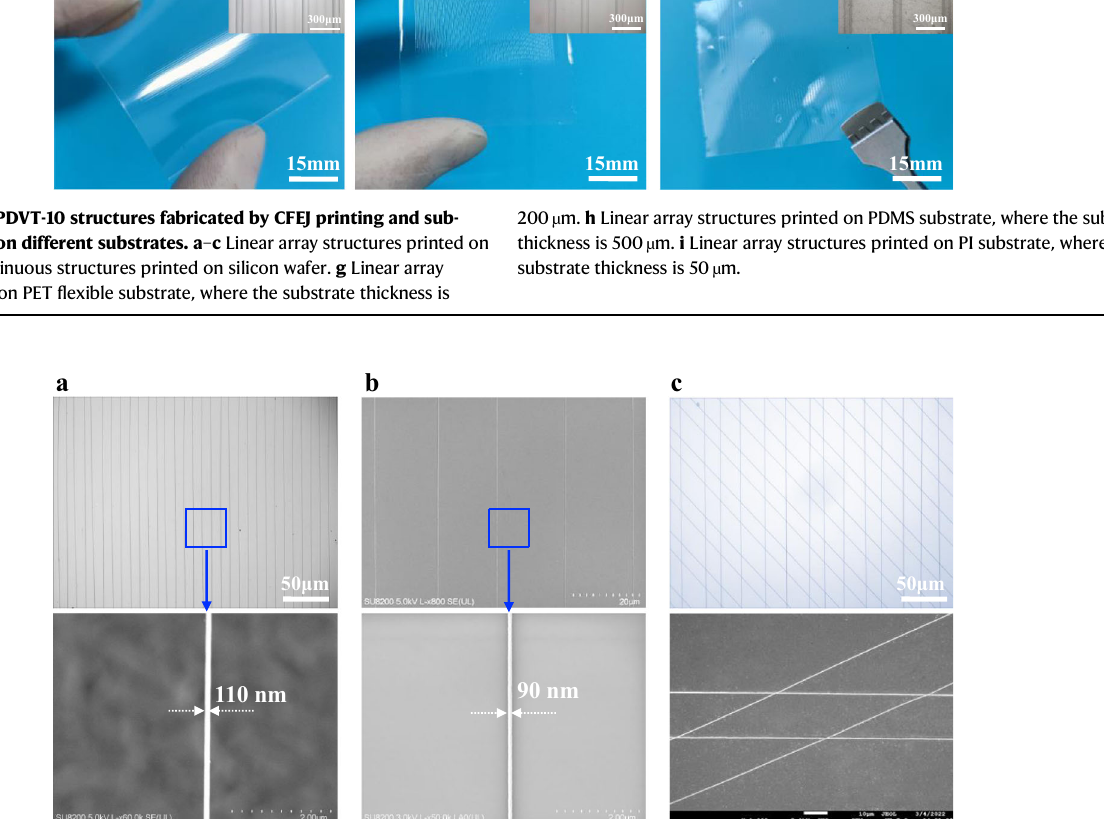
Fig. 3 | Images of various PDVT-10 micro/nanowire arrays fabricated by CFEJ printing. a Aligned sub-microwire arrays printed with a width of ∼ 110nm and its high-magni fi cation image. b Aligned nanowire arrays printed with a width of